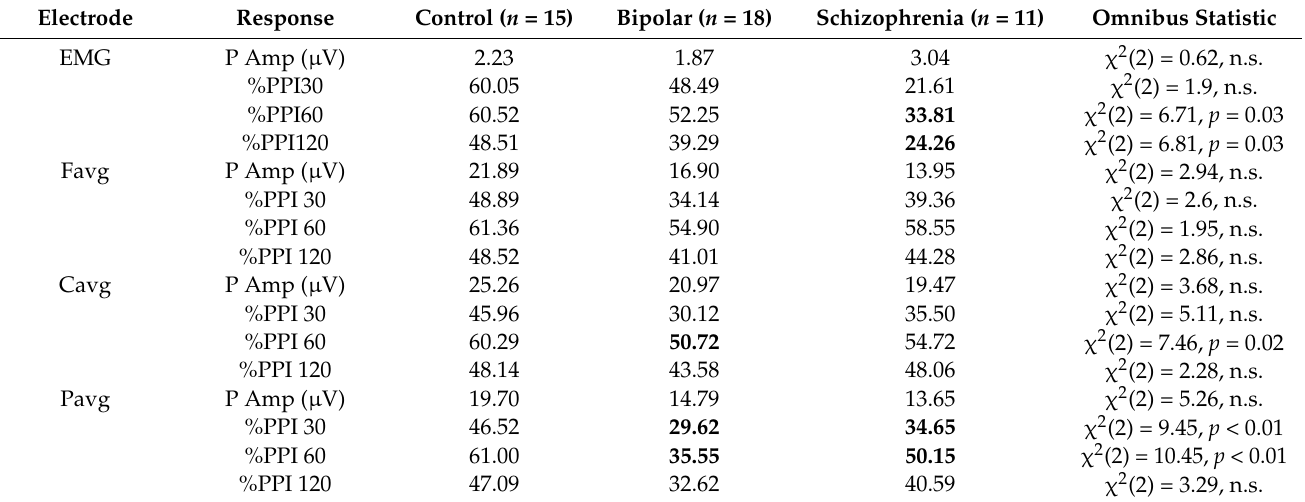
Table 2. Medians of Acoustic Startle Response (ASR) and percentage Prepulse Inhibition for Control, Schizophrenia, and Bipolar Disorder